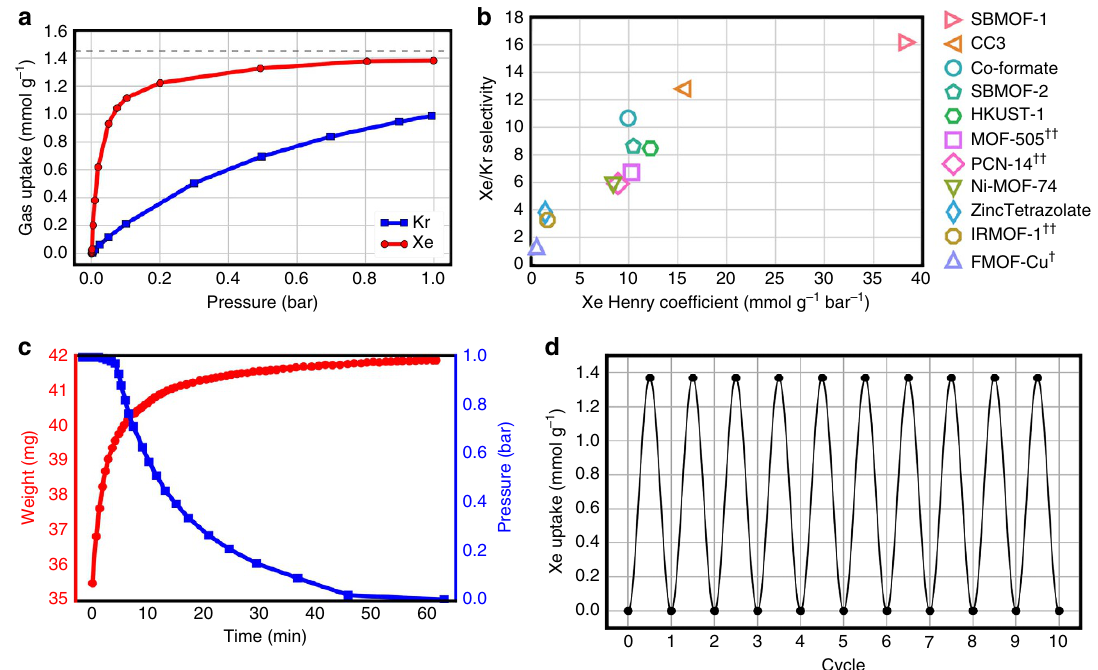
Figure 2 | Experimental characterization of Xe and Kr adsorption in SBMOF-1. ( a ) Experimental Xe and Kr adsorption isotherms. Horizontal line indicates one atom per pore segment. ( b ) Survey of thermodynamic Xe/Kr separation performance in top-performing materials. Henry coefficients are extracted from pure-component Xe and Kr adsorption isotherms reported in the literature (see Methods). Data at 298K, exceptions denoted by a dagger ( w ) for 297K and a double dagger ( ww ) for 292K. ( c ) Xe adsorption kinetics experiments. The blue curve shows the pressure drop in a chamber feeding Xe to an initially evacuated chamber with the SBMOF-1 sample; the red curve shows the corresponding weight increase due to Xe adsorption. ( d ) Xe adsorption/ desorption cycling data; a sinusoidal curve is superimposed on the data. ( a , c , d ) Data for SBMOF-1 at 298K.